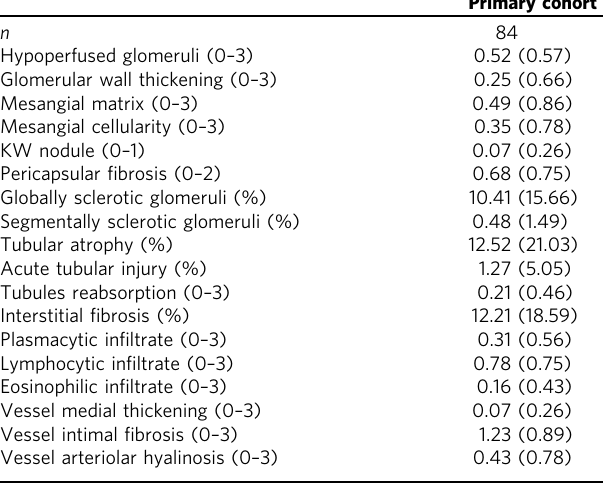
Table 2 Histological characteristics of primary